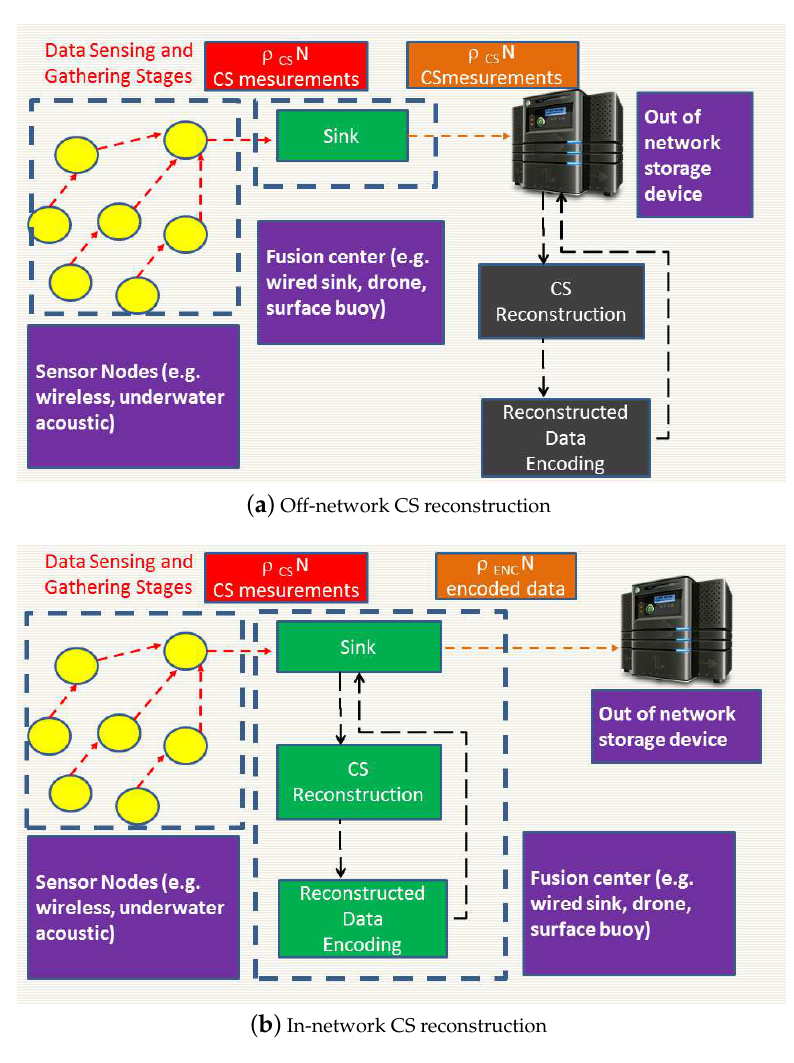
Figure 1. Computing architectures for IoT CS